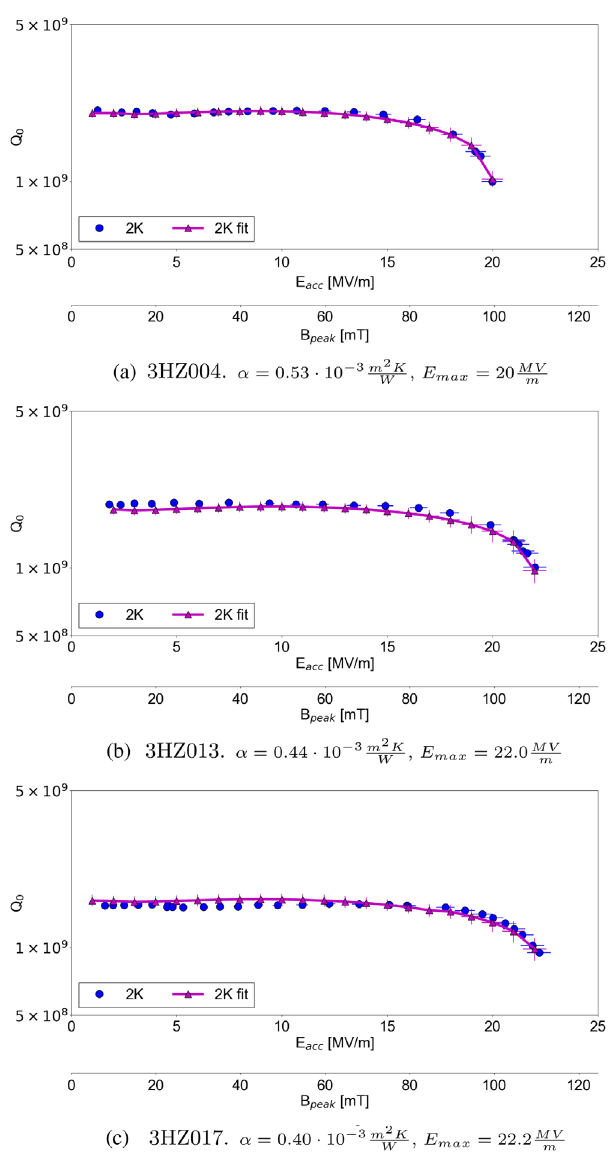
FIG. 11. Comparison between measured and calculated Q 0 vs E curves for cavity 3HZ004 (a), 3HZ013 (b), and 3HZ017 acc (c) at 2 K. Errors on calculated value are also indicated. The estimated overheating parameters and the breakdown fields are reported in the